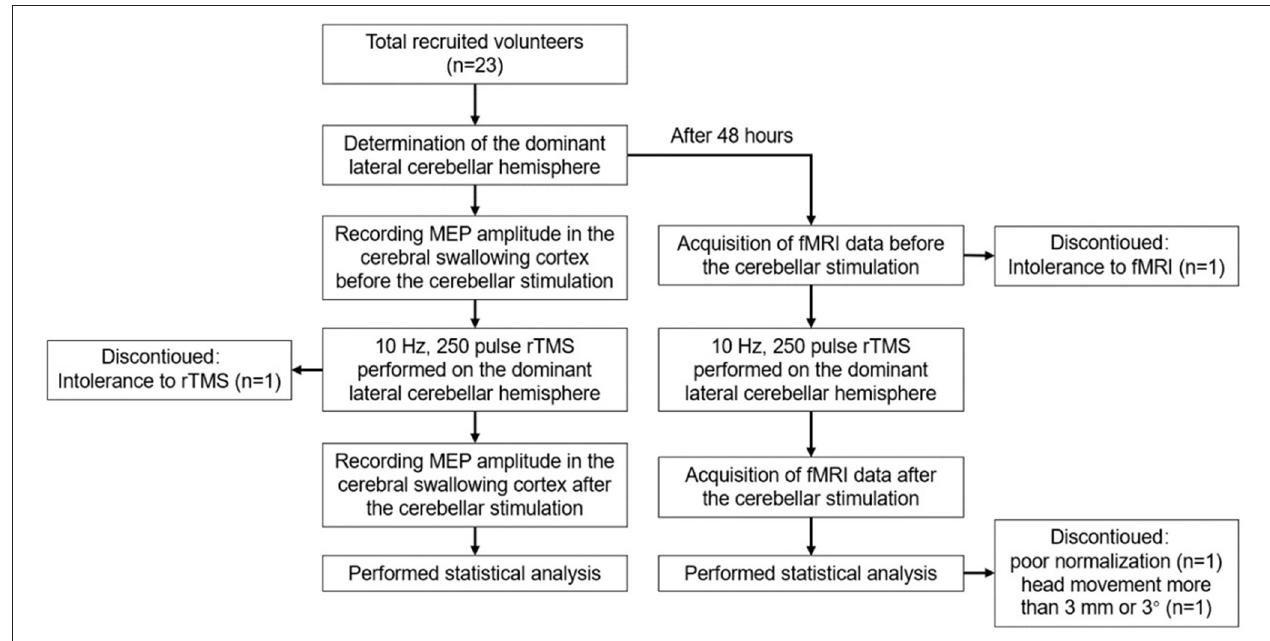
FIGURE 1 | The study design and